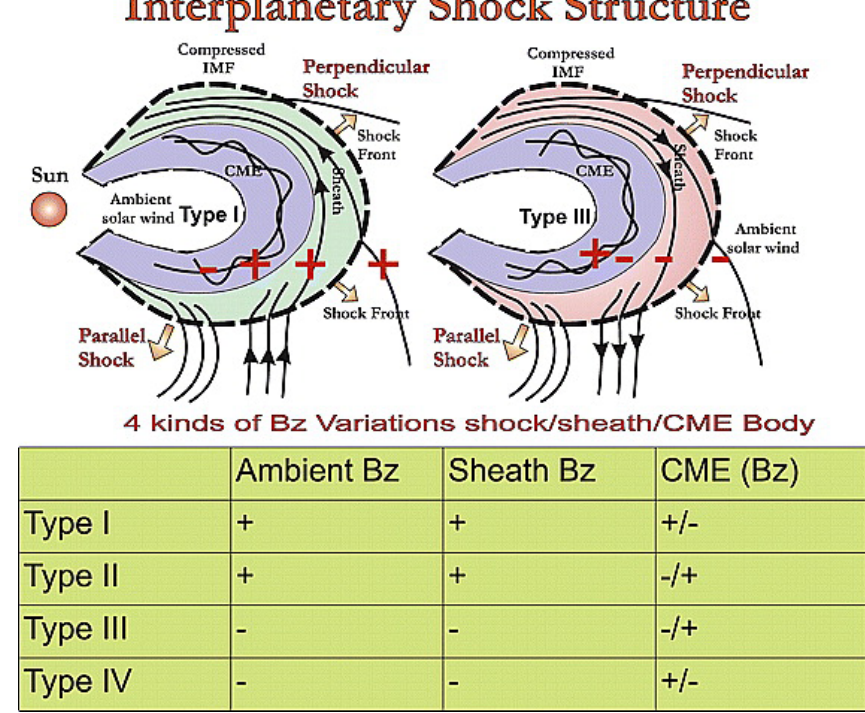
Figure 5. Schematic diagram of the Type I and Type III IP shocks and driven CMEs (Yue and Zong,